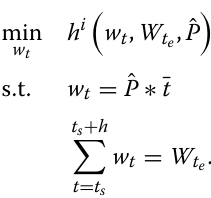
from electricity generation during t s , h